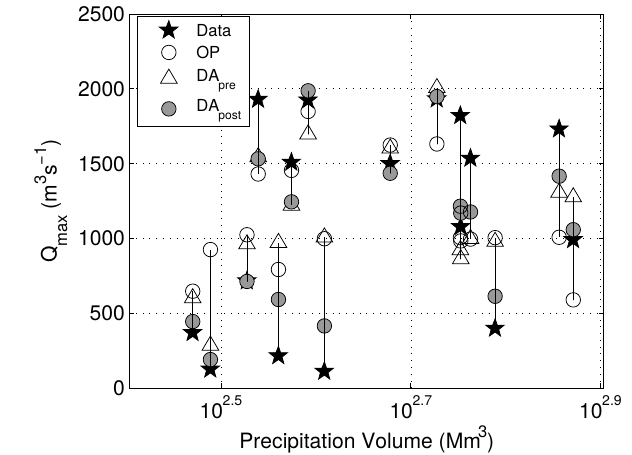
Figure 3. Hydrographs at S. Giovanni alla Vena measurement sta- tion for the false alarm event of 6 April 2010. Flow observations are gray dots, open loop simulation is the solid line, predictions using analysis obtained by assimilating flow data during the 1st, 2nd, 3rd and 4th assimilation window (Assim. Win.) are the dotted, dashed, dash-dot and solid thick line respectively.